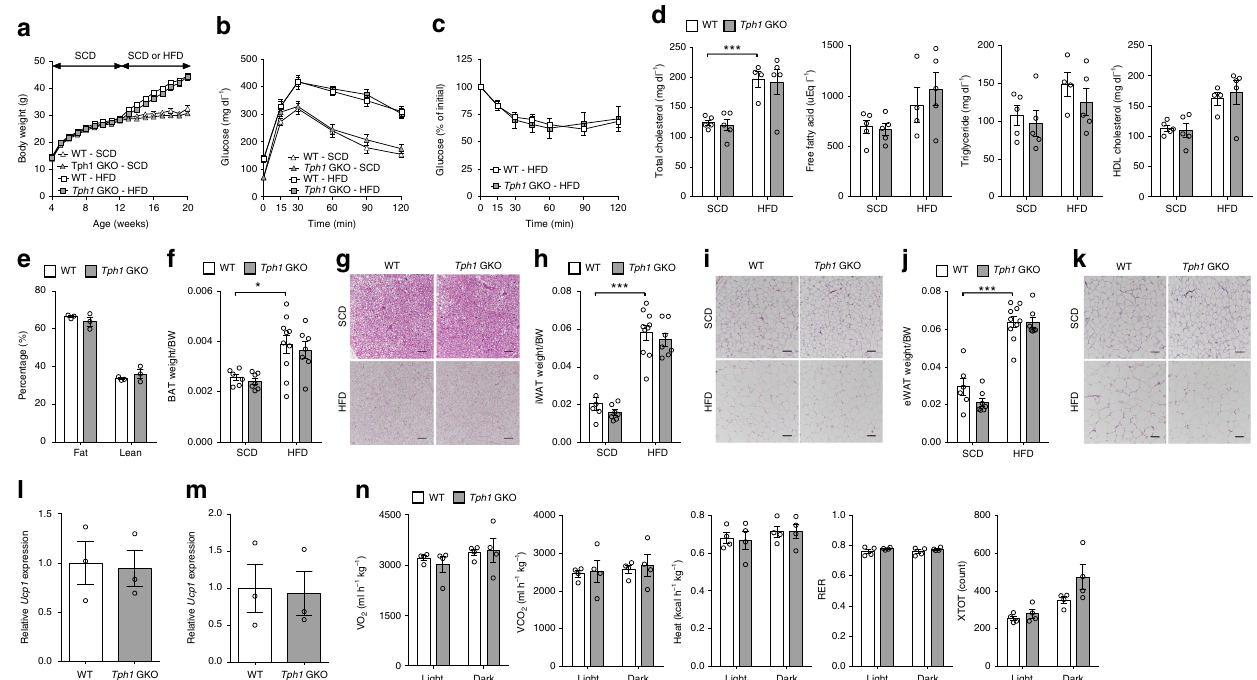
Fig. 2 Gut-derived 5-HT does not affect systemic energy metabolism. a – n The 12-week-old WT and Tph1 GKO mice were fed SCD or HFD for 8 weeks. a Body weight trends; n = 6 – 10 per group. b Intraperitoneal glucose tolerance test (IPGTT) after 16 h fasting; n = 5 per group. c Intraperitoneal insulin tolerance test (IPITT) of HFD-fed WT and Tph1 GKO mice after 4 h fasting; n = 5 per group. d Plasma total cholesterol, free fatty acid, triglyceride, and high-density lipoprotein (HDL) cholesterol levels; n = 4 – 5 per group. e Percent fat body mass and lean body mass of HFD-fed WT and Tph1 GKO mice; n = 3 per group. f , h , j Adipose tissue to body weight ratio of BAT ( f ), iWAT ( h ), and eWAT ( j ); n = 6 – 10 per group. g , i , k Representative histology by H&E staining of sections from BAT ( g ), iWAT ( i ), and eWAT ( k ). Scale bars, 100 μ m. l , m Relative mRNA expression of Ucp1 assessed by qRT-PCR in BAT ( l ) and iWAT ( m ) of HFD-fed WT or Tph1 GKO mice; n = 3 per group. n Metabolic parameters of HFD-fed WT or Tph1 GKO mice; n = 4 per group. Data are expressed as the means ± SEM. * P < 0.5, *** P < 0.001, Student ’ s t -test ( c , e , l , m ) or one-way ANOVA with post hoc Tukey ’ s test ( a , b , d , f, h , j , n